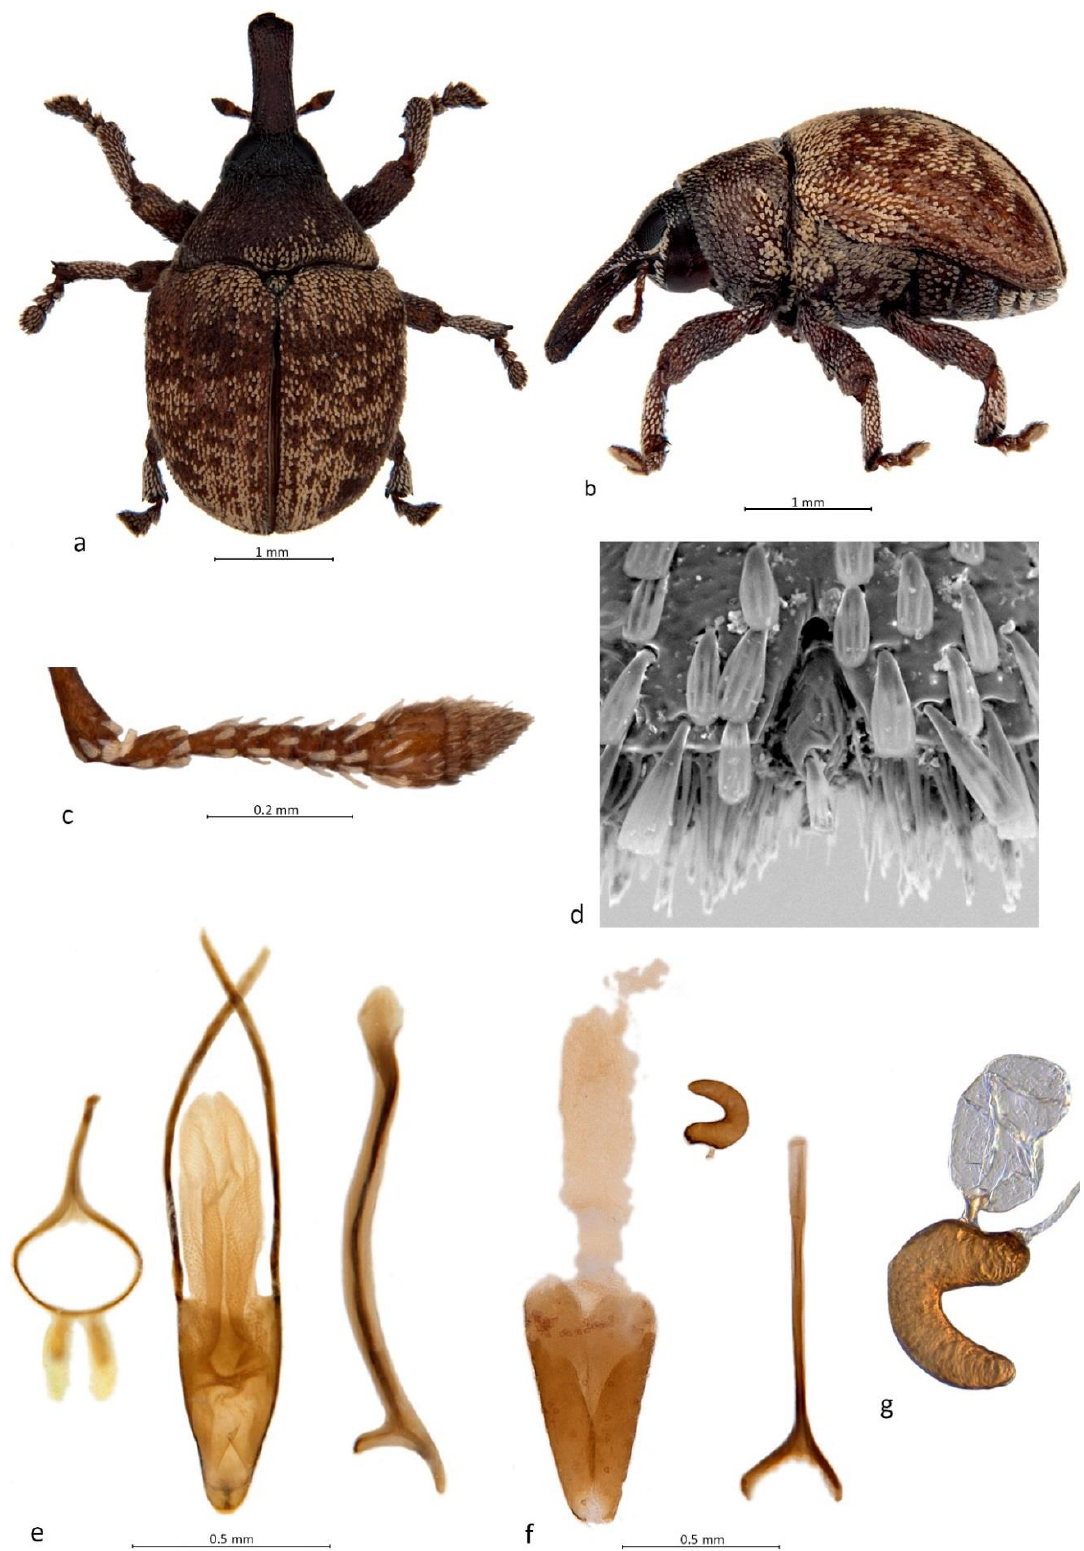
Figure 1. Habitus and diagnostic characters of Cryptoplus Erichson ( C. maculipennis (Lea)): ( a ) habitus of male, dorsal view; ( b ) habitus of male, left lateral view; ( c ) right antenna, male, dorsal view; ( d ) tarsite 3 with onychium, apical view; ( e ) genitalia, male, dorsal view; ( f ) genitalia, female, dorsal view; ( g ) spermatheca with gland.